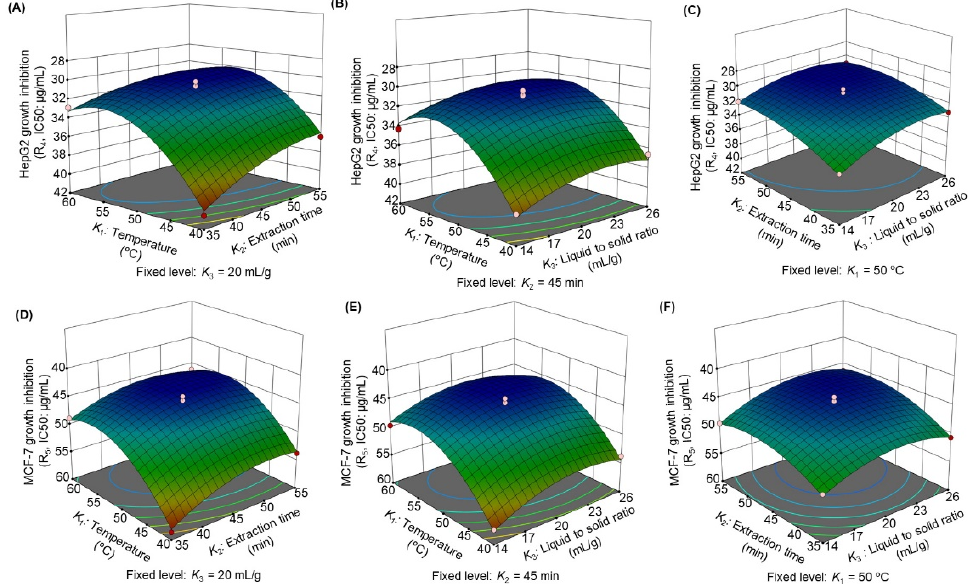
Figure 4. Response surface 3D plots showing the interaction effects of UAE variables on human liver cancer cell line (HepG2; R 4 ) and breast cancer cell line (MCF-7; R 5 ). ( A ) 3-D response surface plots shows the effects of K 1 and K 2 interaction on growth inhibition of HepG2 cells (IC 50 ) at constant K 3 (20 mL/g); ( B ) 3-D response surface plots shows the effects of K 1 and K 3 interaction on growth inhibition of HepG2 cells (IC 50 ) at constant K 2 (45 min); ( C ) 3-D response surface plots shows the effects of K 2 and K 3 interaction on growth inhibition of HepG2 cells (IC 50 ) at constant K 1 (50 °C); ( D ) 3-D response surface plots shows the effects of K 1 and K 2 interaction on growth inhibition of MCF-7 cells (IC 50 ) at constant K 3 (20 mL/g); ( E ) 3-D response surface plots shows the effects of K 1 and K 3 interaction on growth inhibition of MCF-7 cells (IC 50 ) at constant K 2 (45 min); ( F ) 3-D response surface plots shows the effects of K 2 and K 3 interaction on growth inhibition of MCF-7 cells (IC 50 ) at constant K 1 (50 °C).